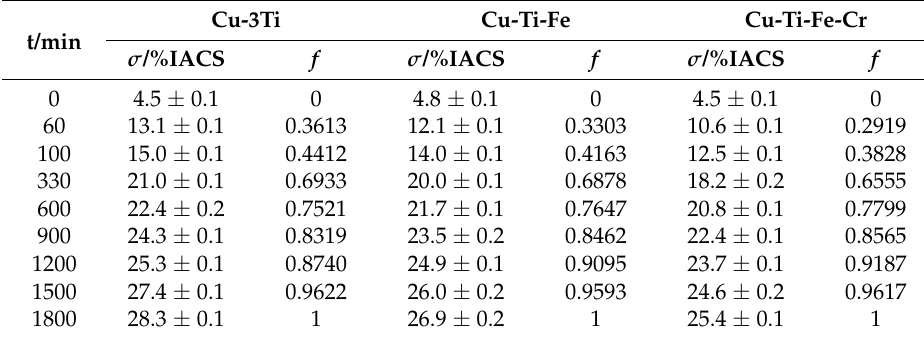
Table 3. Electrical conductivities and volume fractions of the three alloy foils, with different aging times, at 450 ◦